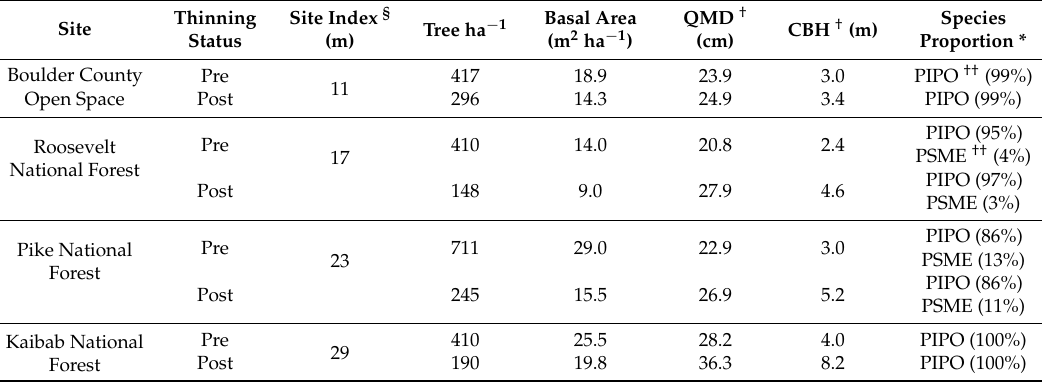
Table 1. Pre and post-treatment conditions for the four simulation